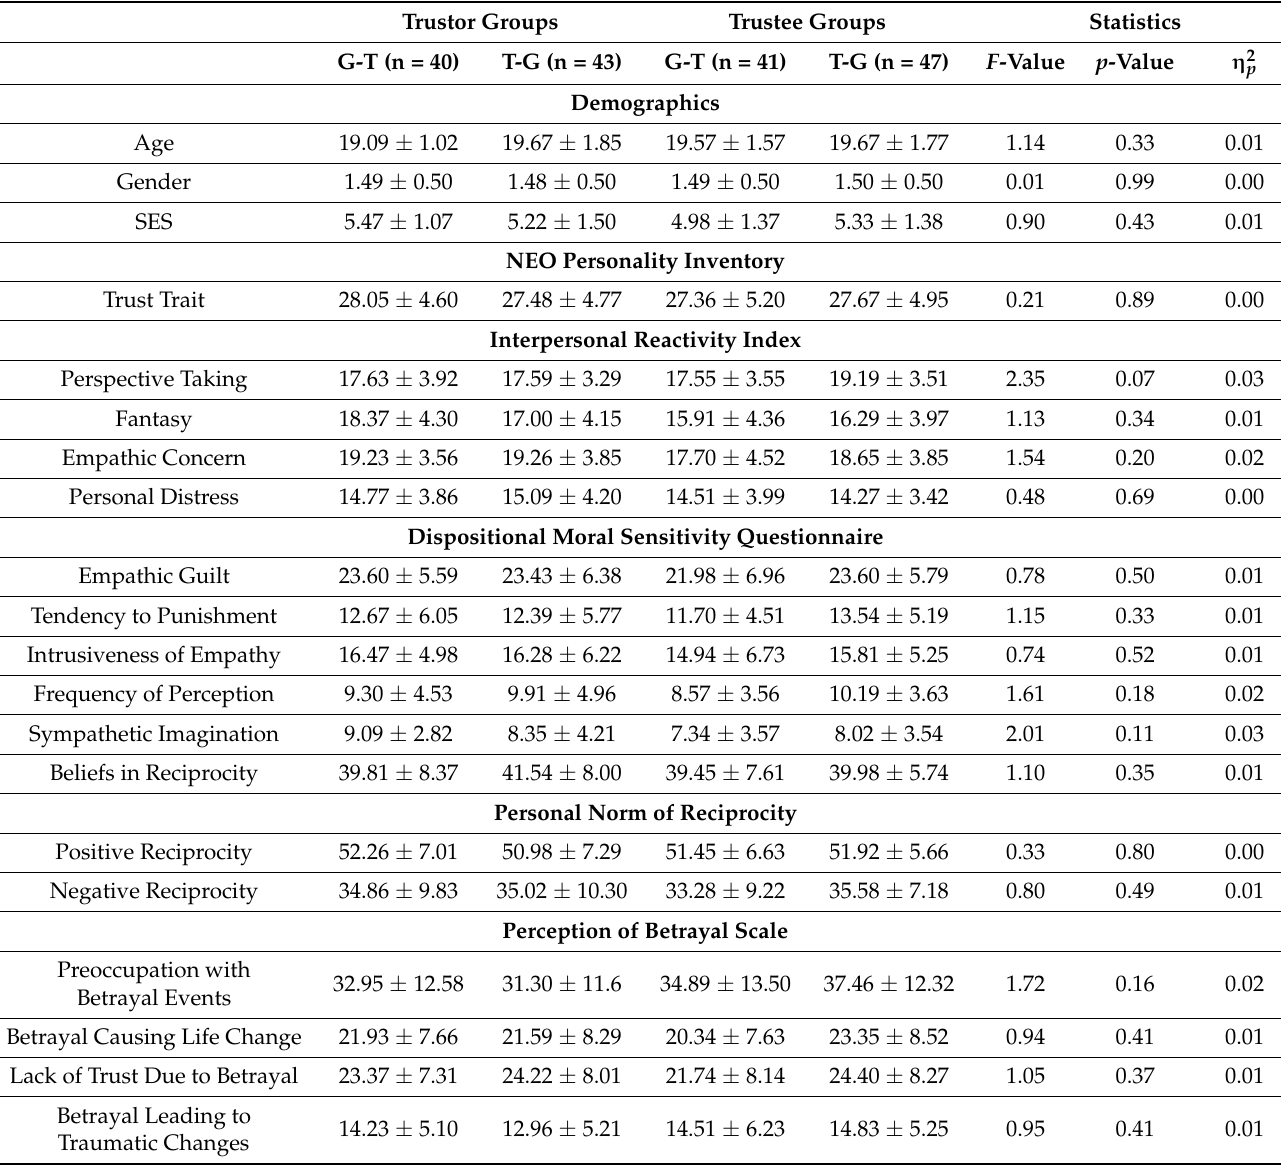
Table 1. Descriptive (mean ± standard deviation) and inferential statistics ( p < 0.05) of demographics and self-report control questionnaire measures of four groups of participants with different frame orders (G-T: Give-Frame then Take-Frame or T-G: Take-Frame then Give-Frame).